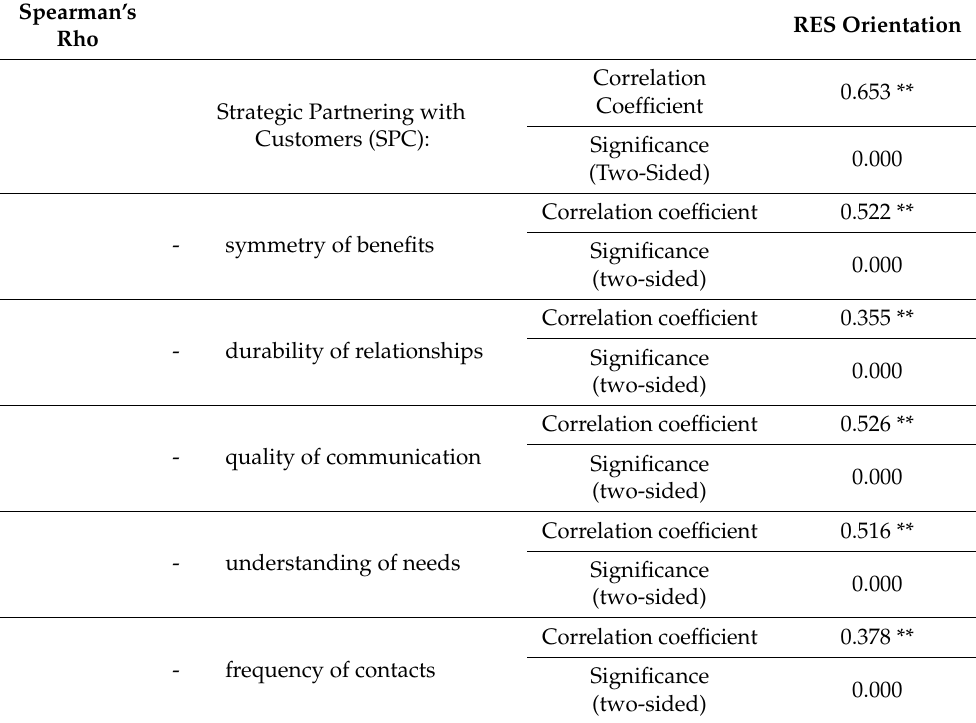
Table 4. Correlation between SPC and RES orientation ( n